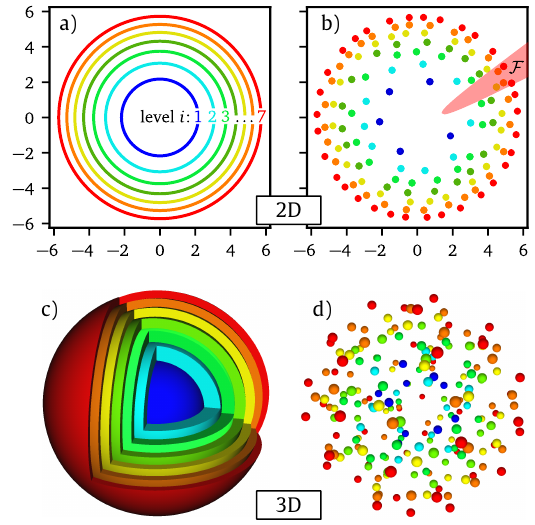
Figure 1. The first seven levels of exploration sets (layers) in N var = 2 and N var = 3 dimensional standard Gaussian space. Panels a,c: nested N var -balls. Panels b,d: realizations of random exploration